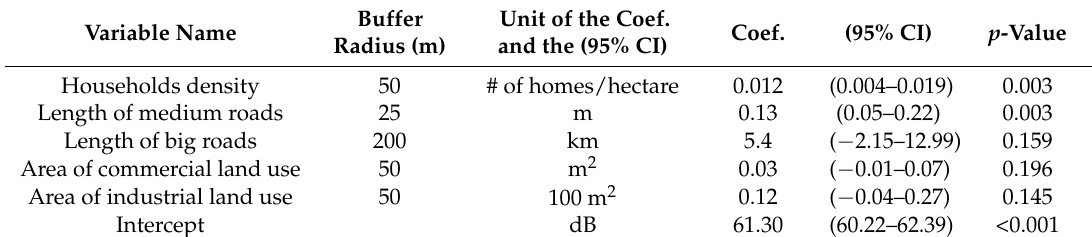
Table 3. Results of the LUR model developed during a stepwise forward stepwise backward selection, and with only GIS variables in order to explain L den measured at 134 sample sites (adjusted R 2 = 0.130). The coefficient (coef.) refers to L den increase per unit of the predictor